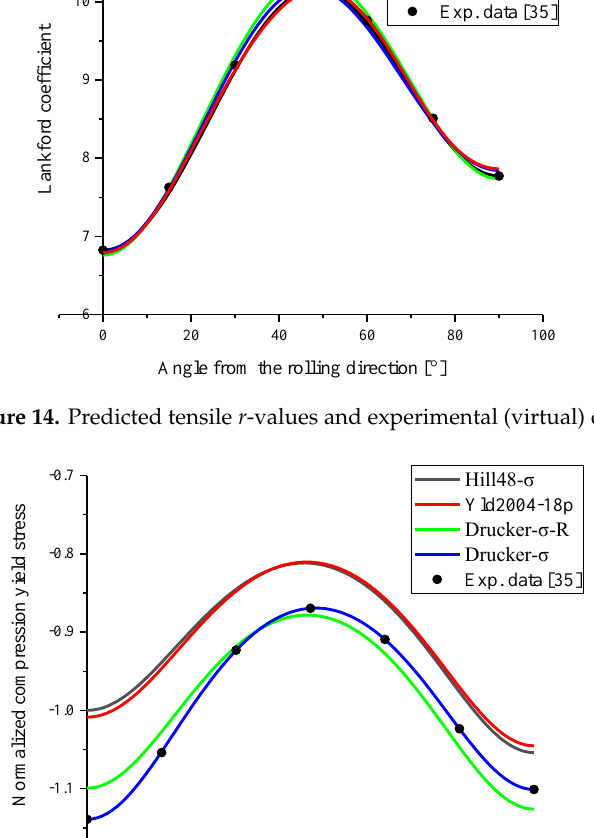
Figure 15. Predicted normalized compressive yield stresses and experimental (virtual) data.